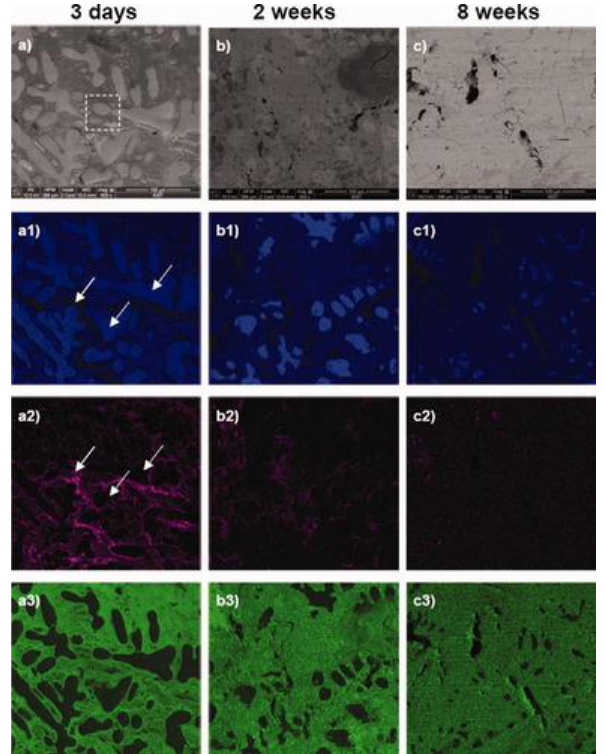
Figure 24. Comparison of elemental mapping of the cross-sections of cylindrical Mg–Ca specimens, which were implanted in the subchondral bone of rat femoral condyle, at ( a ) 3 days, ( b ) 2 weeks, and ( c ) 8 weeks post-implantation. ( a–c ) Cross-sectional SEM images acquired by a BSE detector. EDS elemental maps show the distributions of Mg ( a1–c1 ), Ca ( a2–c2 ) and O ( a3–c3 ). The white dotted arrows direct to Mg-depletion traces (a1) and Ca-rich lines (a2) between primary Mg particles and the lamellar structures. The in vivo corrosion is macroscopically governed by the interdiffusion of Ca and O along the three-dimensional lamellar network and by the simultaneous surface diffusion of the primary Mg phase [292]. Reprinted with permission from John Wiley & Sons, Inc.